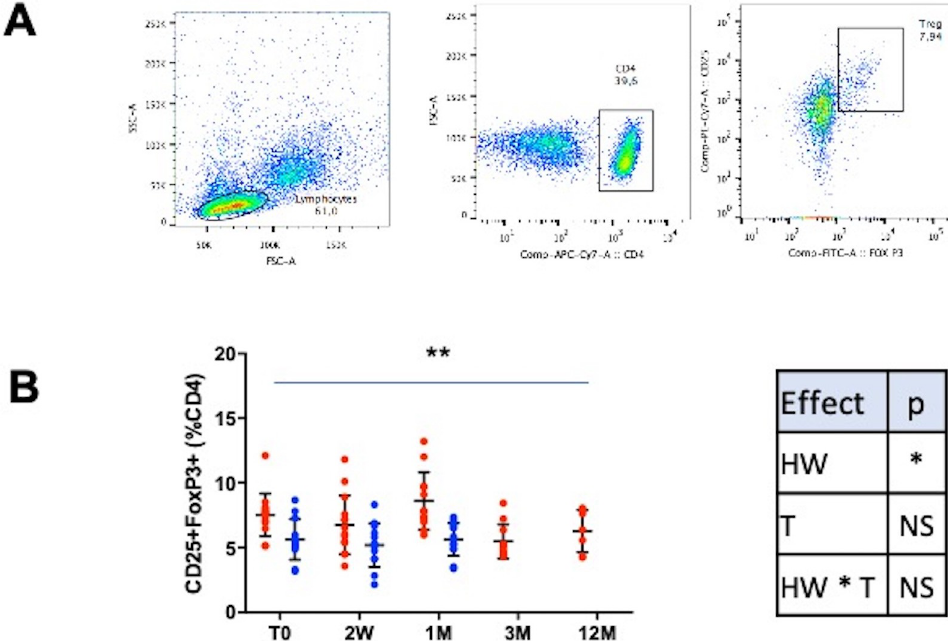
Fig 1. Treg. A: Gating strategy. B: Results are expressed as mean +/- SD. HW+: population infected with hookworm, HW-: control group, 2W: 2 weeks, 1M: 1 month, 3M: 3 months and 12M: 12 months after treatment. The HW+ group is represented with red dots and the HW- group with blue dots. To compare the HW+ and HW- groups and their evolution, a maximum likelihood analysis has been used to test a group (HW), a time (T) and a group � time (HW � T) interaction effects (with data at T0, 2W and 1M). Statistical results are summarized in correspondent tables for each parameter. To compare longitudinal data from the HW+ group (T0, 2W, 1M, 3M and 12M), a time and a time 2 effects were tested. The time effect is depicted on the figures and the time 2 effect is given in the results section ( � p < 0.05, �� p < 0.01, ��� p < 0.001).